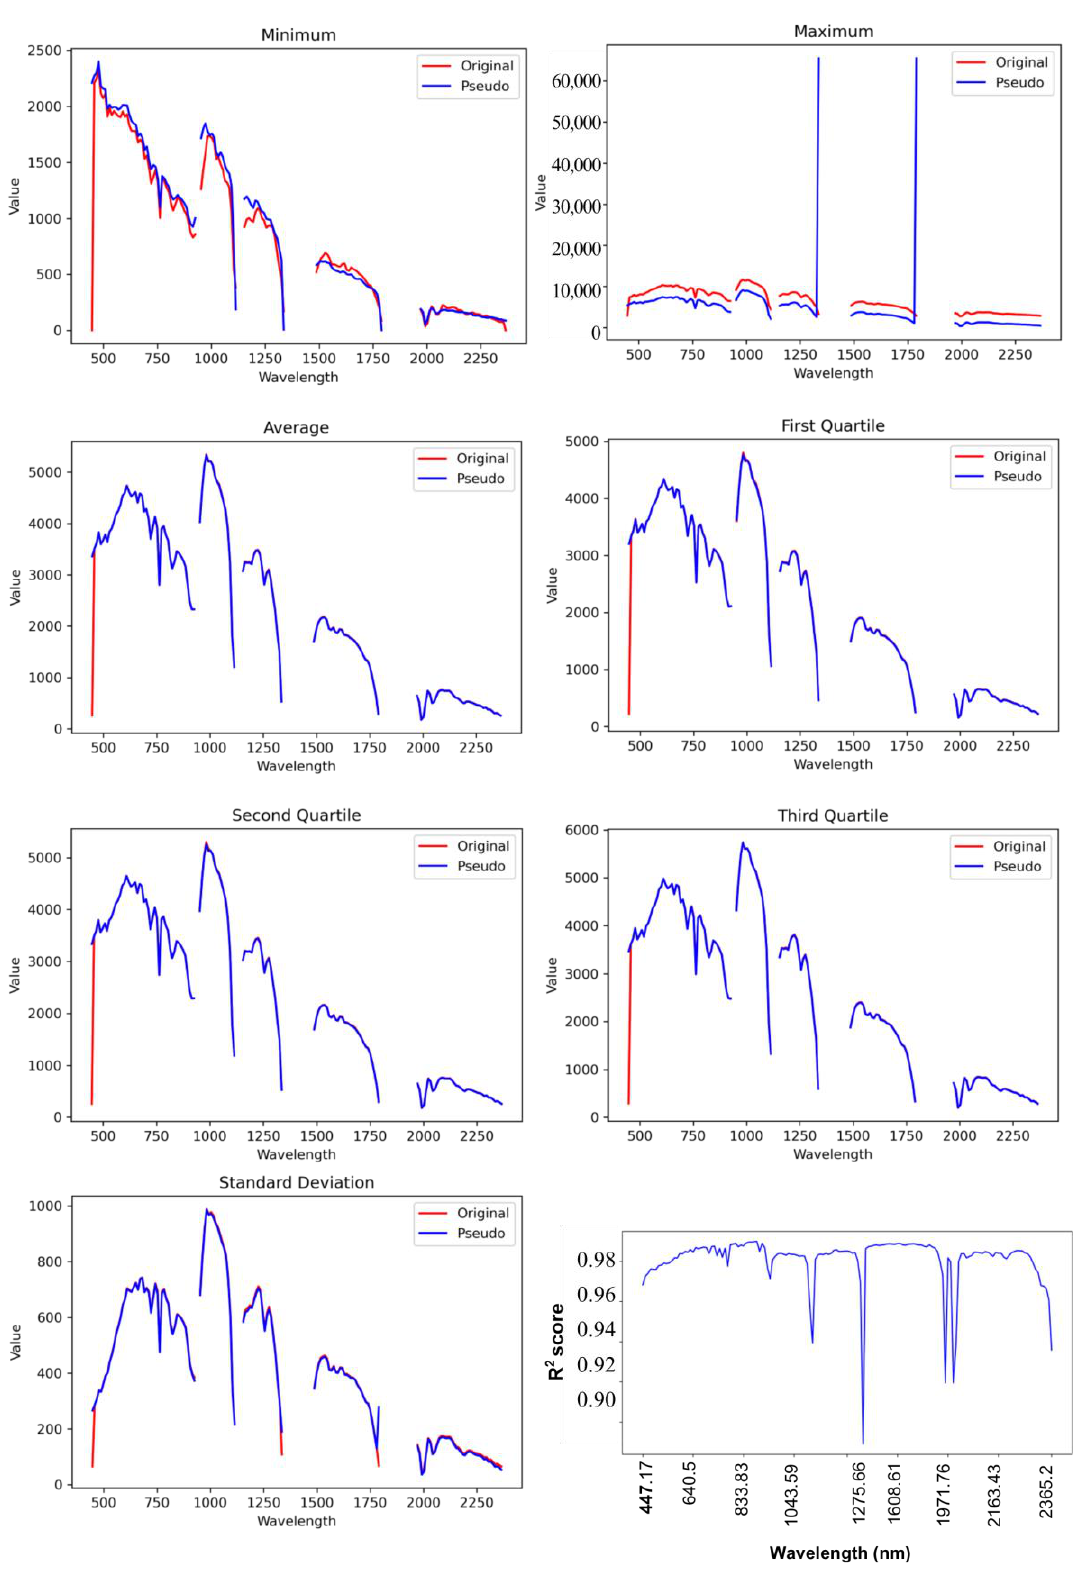
Figure 7. Summary statistics for original vs. predicted hyperspectral bands along with the R2 score between them and their violin plot.